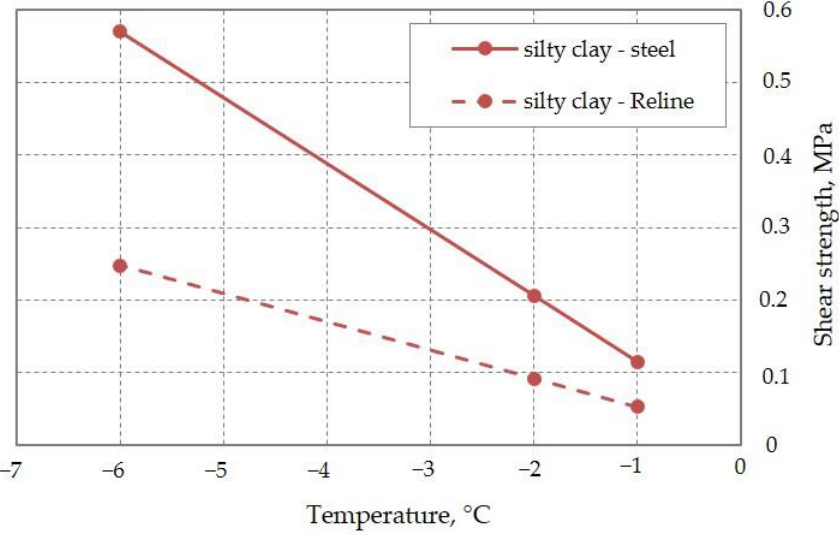
Figure 8. Temperature dependence of shear strength: silty clay-steel and silty clay- Reline .